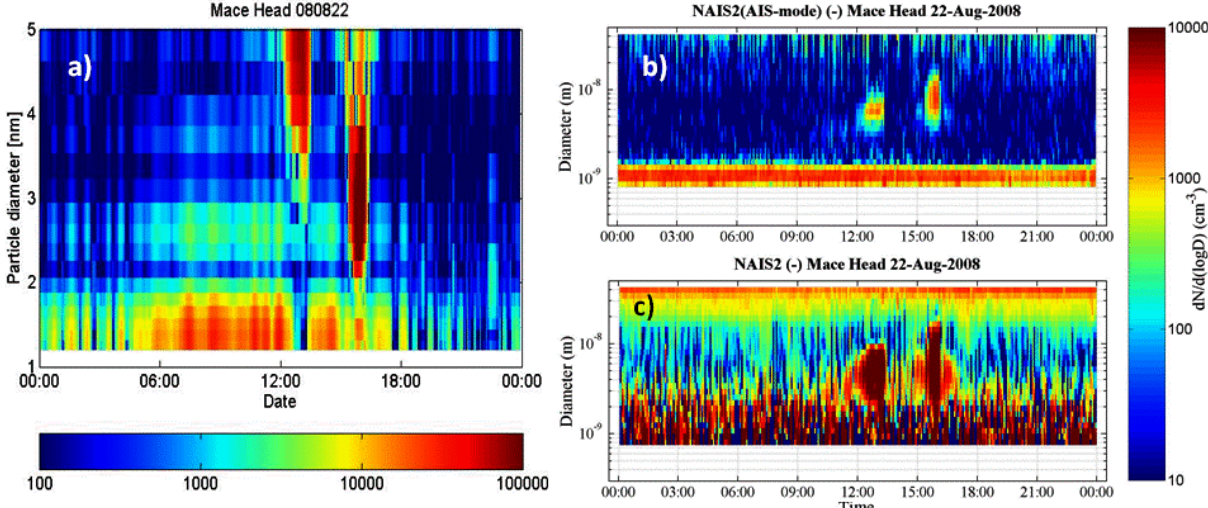
Fig. 6. Size distribution of 1.3–5nm particles measured with the PH-CPC (a) , 0.8–40nm negative ions (b) , and total particle distribution (c) measured with the NAIS in Mace Head 22 August 2008. Low tide occurred around 03:30 and